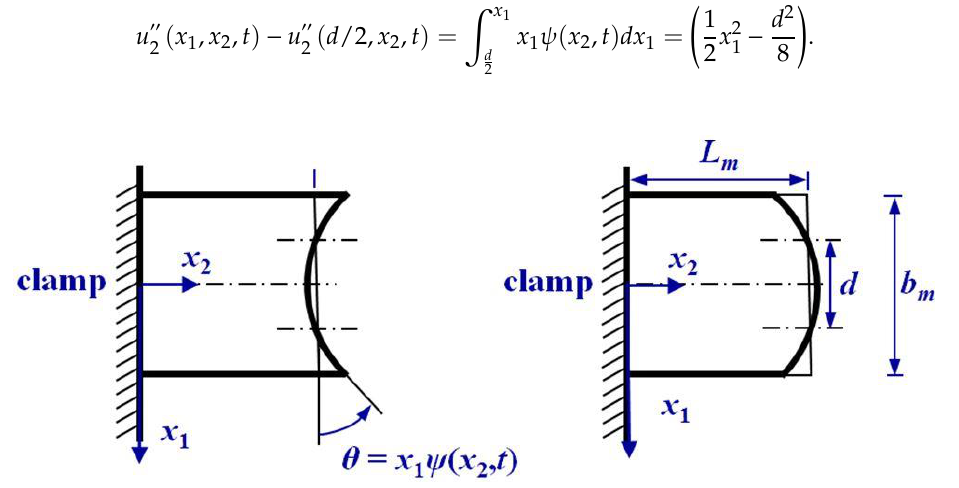
Figure 7. Wrapped curve of the cross-section of the proof mass.